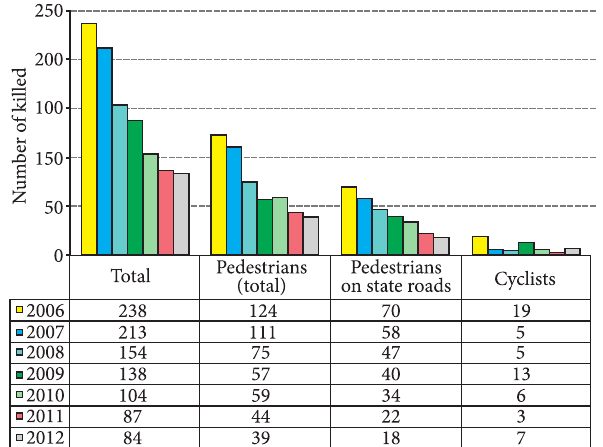
Fig. 5. Number of killed in darkness and twilight in